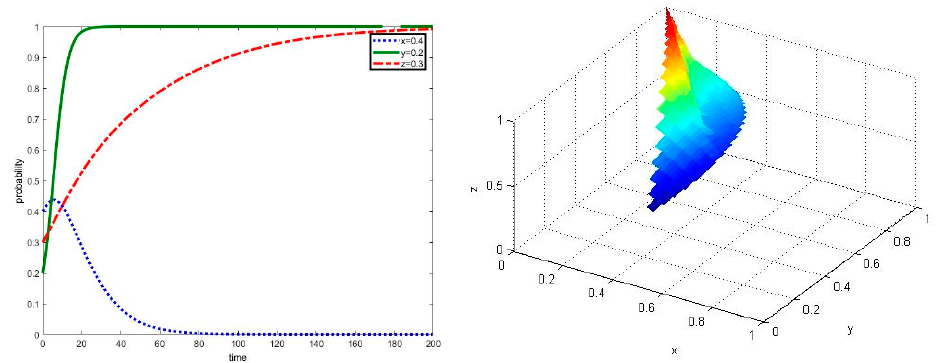
Figure 3. Simulation of dynamic evolution in the scenario of parameters under the conditions of ⑤ .